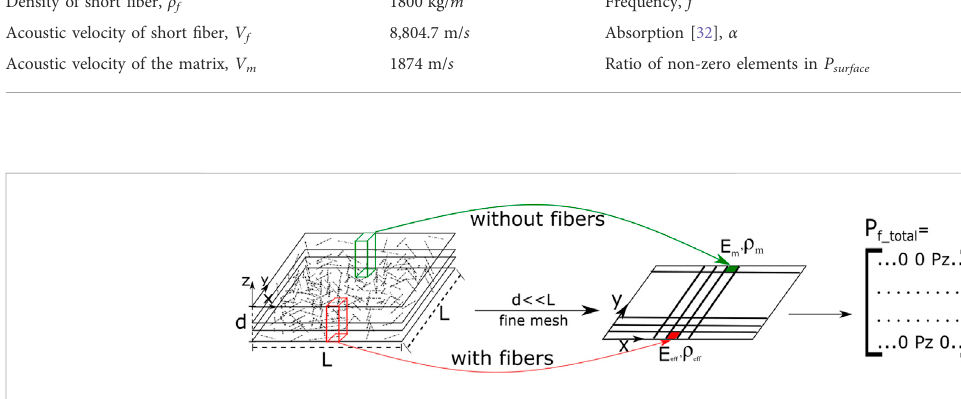
FIGURE 1 Simpli fi ed model of additive manufactured short fi ber composites.